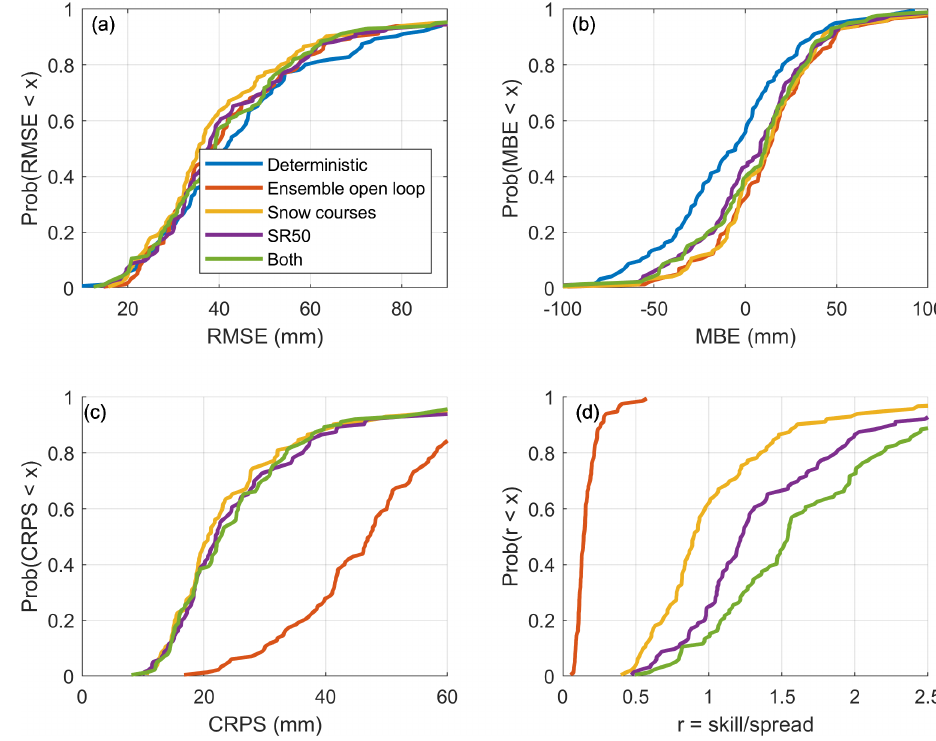
Figure 10. Cumulative distributions of the scores for the validation sites according to the nature of the assimilated